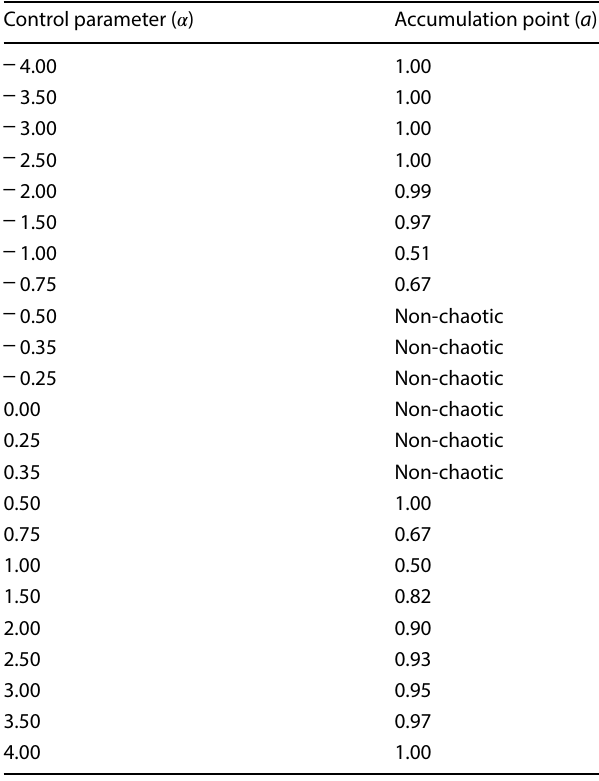
Table 1 Shows the 𝛼 values and corresponding accumulation points correct to 2 decimal places for the GSM